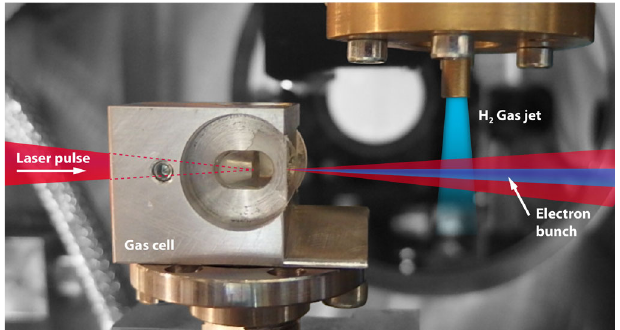
FIG. 1. Photograph of the experimental setup: the laser pulse, incident from the left, drives an LWFA stage in a mixed-species gas cell, and the generated electron beam expands in vacuum according to its divergence. If the second gas jet is turned on, the ≈ 80 mrad) preionizes the transmitted diverging laser pulse ( θ div ≈ 2 . 5 mrad) experi- H 2 gas and the trailing electron beam ( θ div ences plasma lensing, which reduces the divergence substantially as observed on a scintillation screen (Figs. 2(a) and